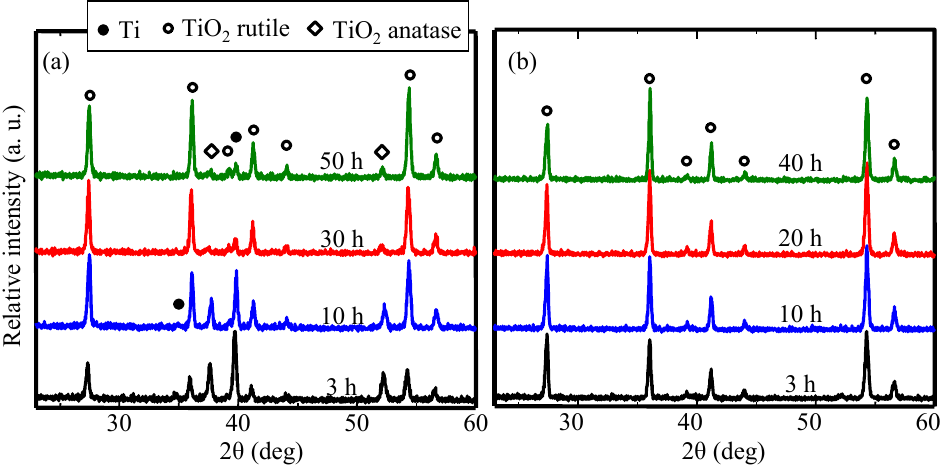
Figure 34. XRD patterns of the of M10- x K- y h samples. ( a ) 973 K and ( b ) 1073 K.